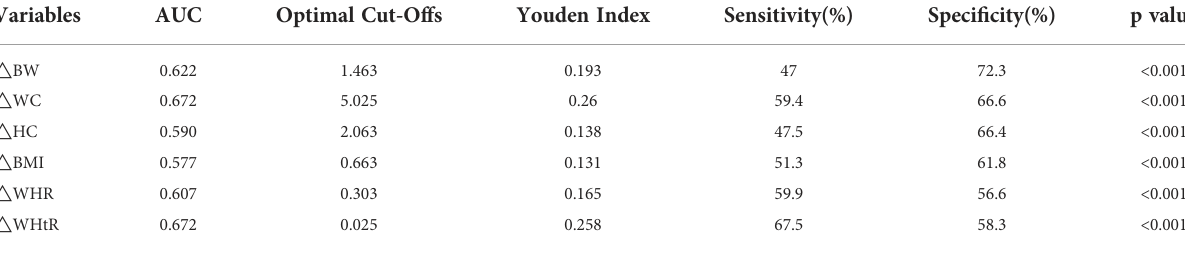
TABLE 3 Receiver operating characteristic (ROC) curve related